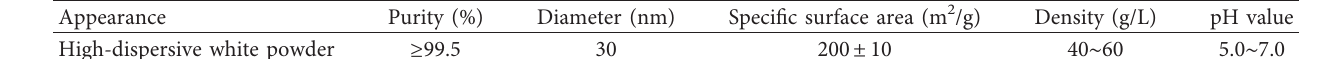
Table 3: Properties of nanosilica.